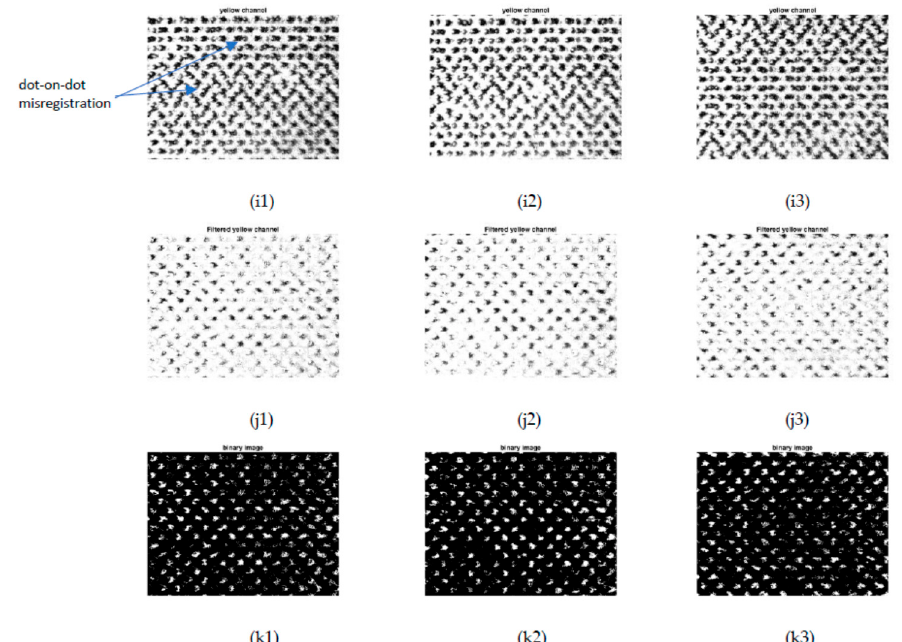
Figure 16. Robustness of the dot patterns detection method relatively to the printing device. (a1) CMYK Image (printed with printer P2 and ink DIC) (cyan dots have a cell angle of 30° and magenta dots have a cell angle of 60°), (a2) Another CMYK Image (cyan dots have a cell angle of 30° and magenta dots have cell angle of 60°), (a3) Another CMYK Image (cyan dots have a cell angle of 30° and magenta dots have cell angle of 60°), (b) to (e) results step by step for C color channel, (f) to (h) results step by step for M color channel, (i) to (k) results step by step for Y color channels.